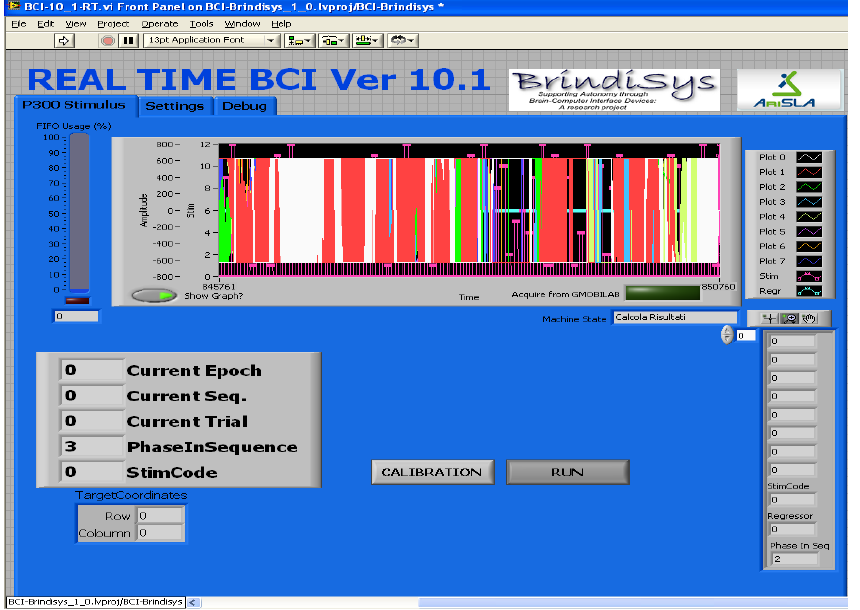
Figure 8. FPGA-embedded BCI interface: the operator can assess the correct functioning during the run phase, or he/she can manage the calibration phase.